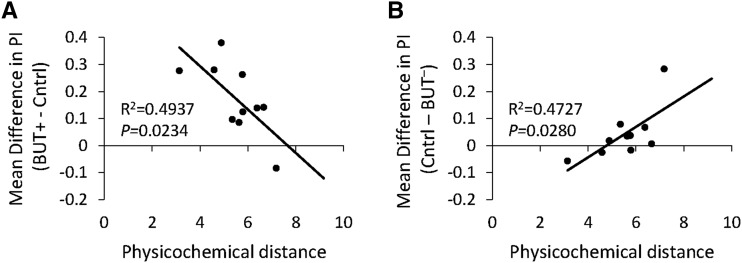
Linear regression analyses reveal a significant correlation between mean PI and physicochemical similarity among lines selected for behavioral responses to 2,3-butanedione (BUT). (A) There is a significant negative correlation between PI and physicochemical distance. The mean difference in PI was calculated by subtracting the mean PI of the three replicate control lines from the mean PI of the three replicate BUT+ lines. (B) There is a significant positive correlation between PI and physicochemical distance. The mean difference in PI was calculated by subtracting the mean PI of the three replicate BUT- lines from the mean PI of the three replicate control lines. Physical distance was calculated as described in Haddad et al. (2008).